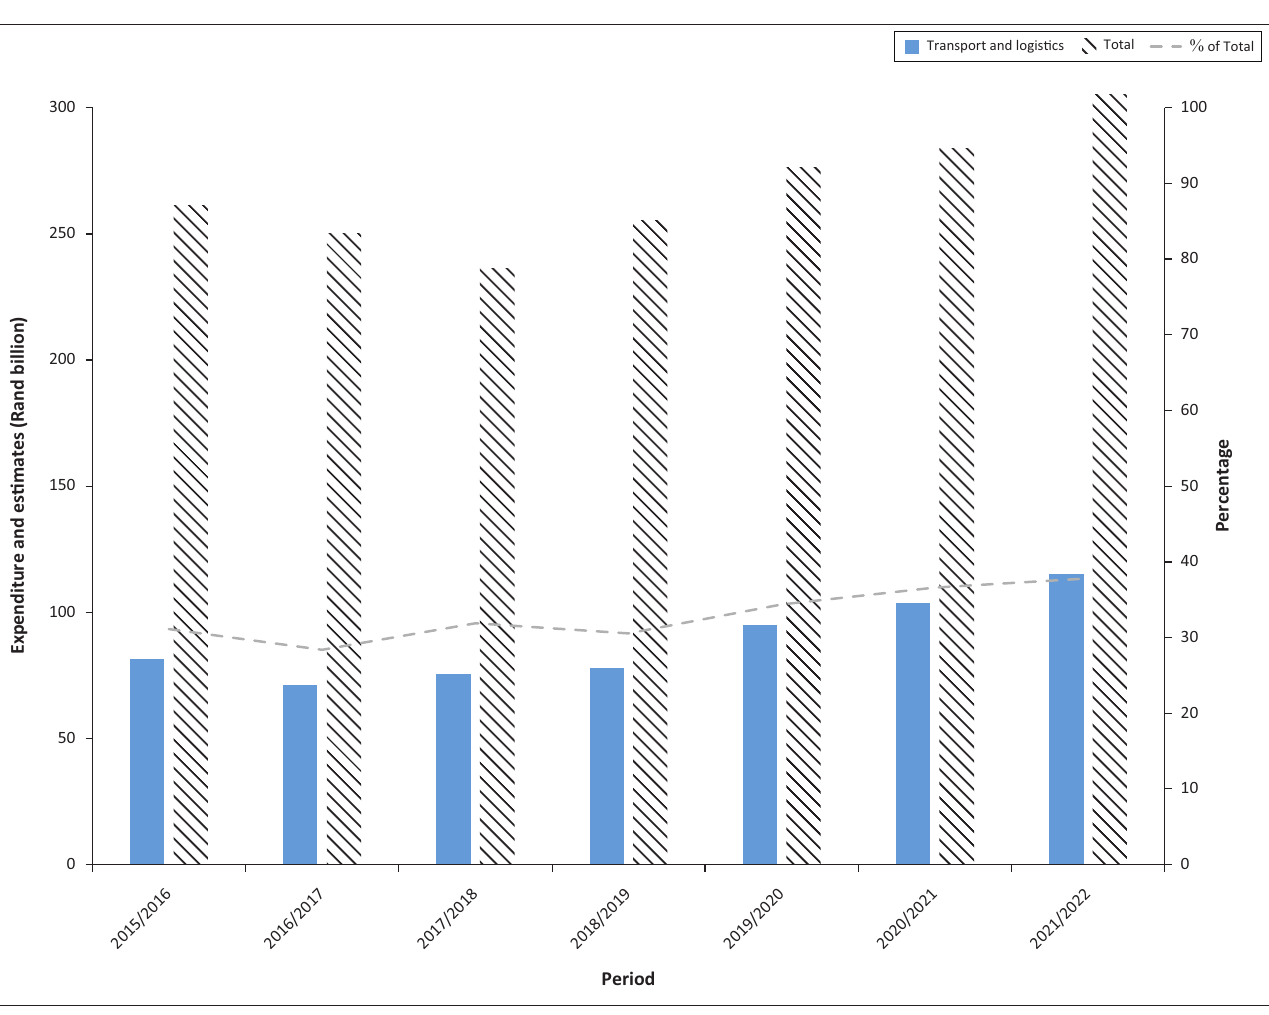
FIGURE 3: Infrastructure expenditure and estimates in South Africa (2015/2016 to